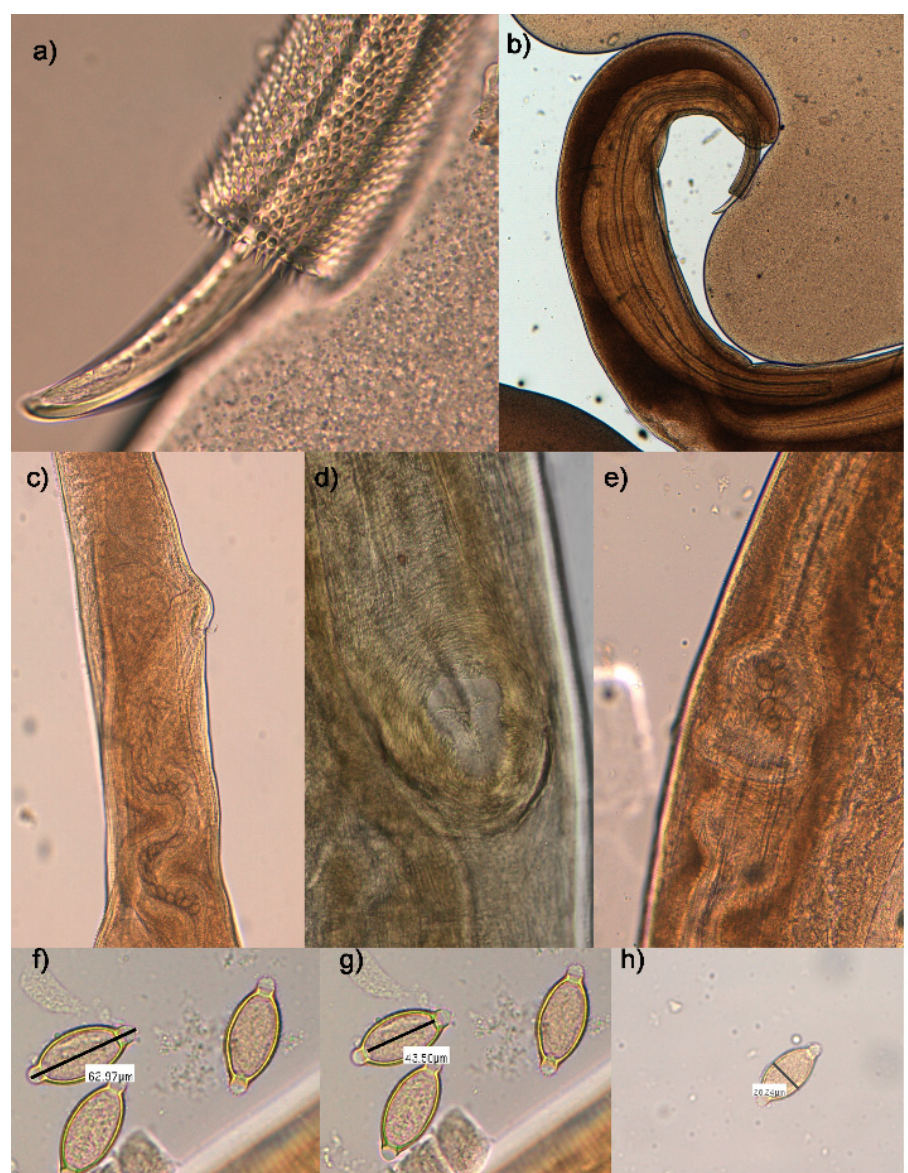
Figure 1. Optical microscopy pictures of Trichuris sp. adult specimens of males ( a , b ) and females ( c – e ). In detail: ( a ): detail of the spines of distal spicular sheath, lateral view; ( b ) entire spicule, with portion of spiny spicular sheath, similar size and morphology of spines, and spicule; ( c , e ) lateral view of protrusive vagina tulip-shaped uterus with eggs; ( d ) detail on frontal vagina view. ( f – h ): measurements of eggs parameters.